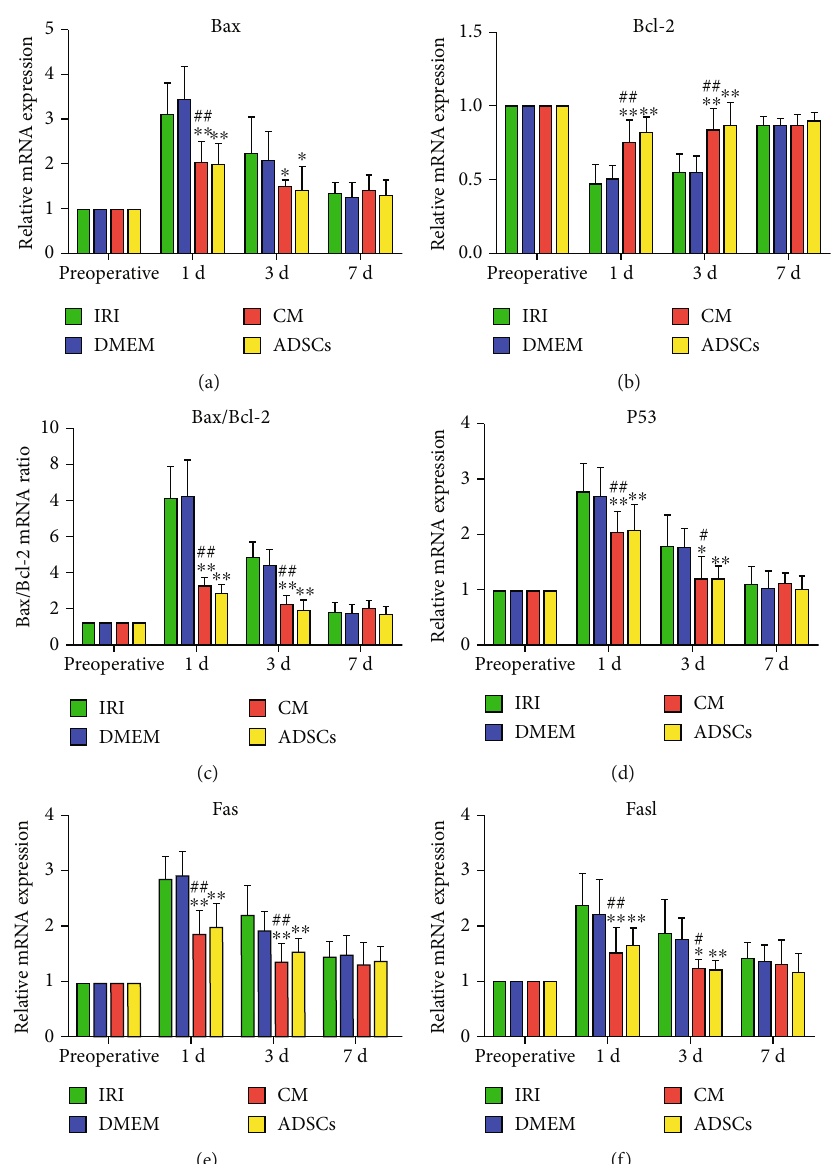
Figure 4: Expression levels of apoptosis-related genes in liver tissue. ∗ P < 0 : 05 and ∗∗ P < 0 : 01 compared to IRI group; # P < 0 : 05 and ## P < 0 : 01 compared to DMEM